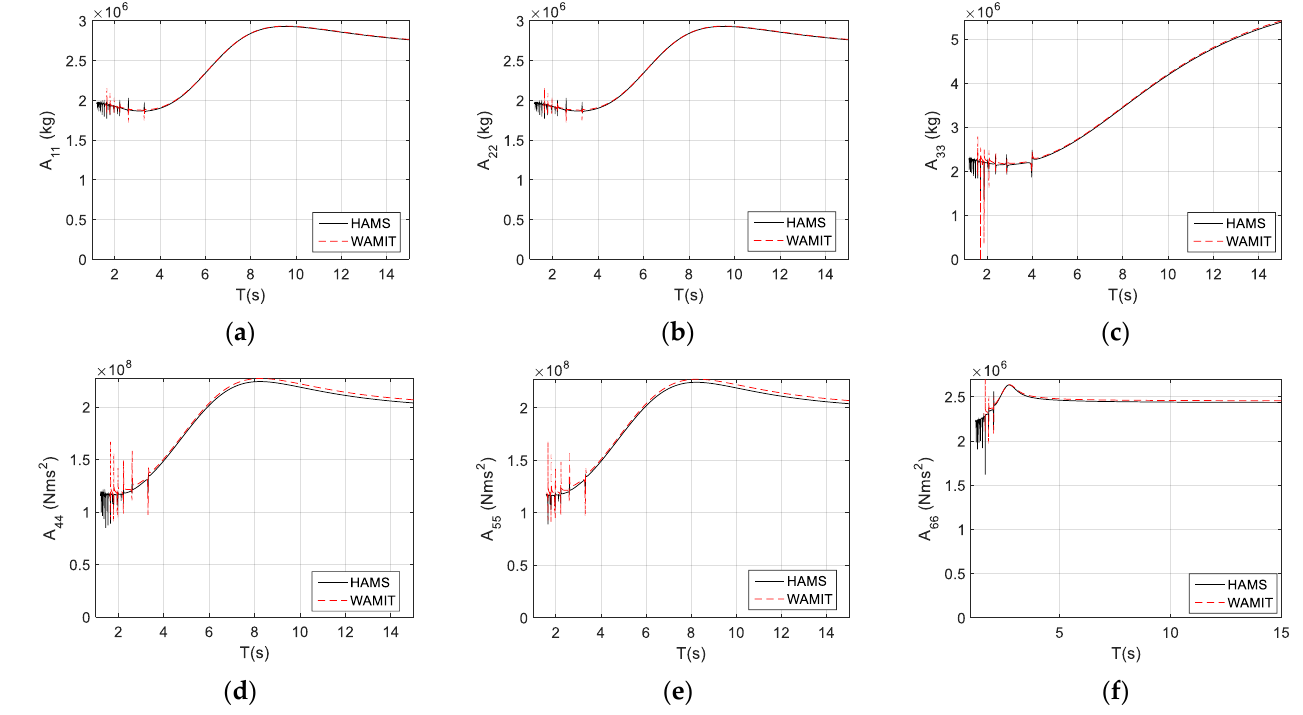
Figure 2. The conventional added-mass dampening of the TALOS structure. ( a ) A 11 ; ( b ) A 22 ; ( c ) A 33 ; ( d ) A 44 ; ( e ) A 55 ( f ) A 66 for motions of surge, sway, heave, roll, pitch, and yaw,